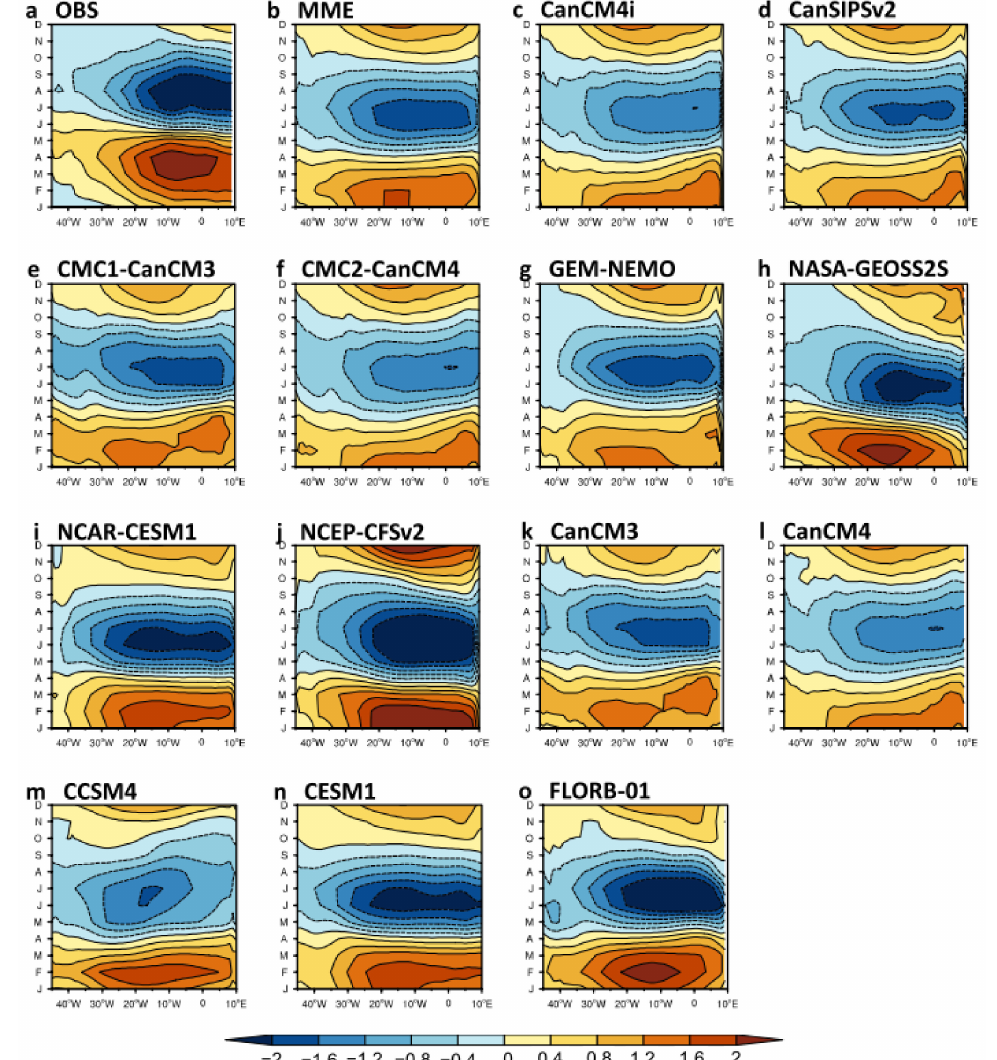
Figure 10. Annual cycle of SST along the equatorial Atlantic (averaged on 3 ◦ S–3 ◦ N) for ( a ) the observation, ( b ) MME and ( c – o ) the individual models. Here the mean SST subtracting the annual mean SST denotes the annual cycle of SST, and the SST annual cycle for the MME and the individual models are derived from the four-month-lead forecast results, which resemble those in the other lead time